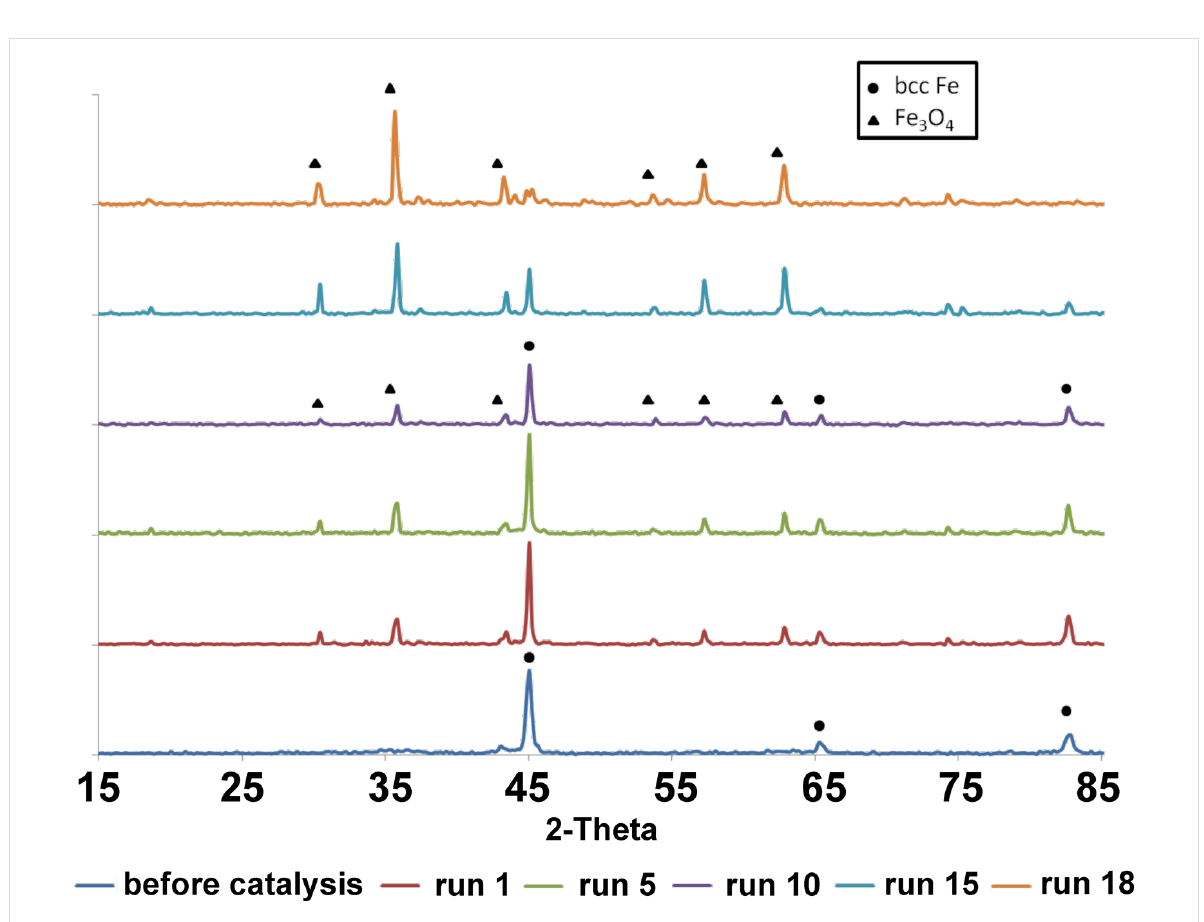
Figure 4: XRD patterns of the Fe/Fe 3 O 4 nanoparticles as a function of catalytic run (2 h at 400 °C).